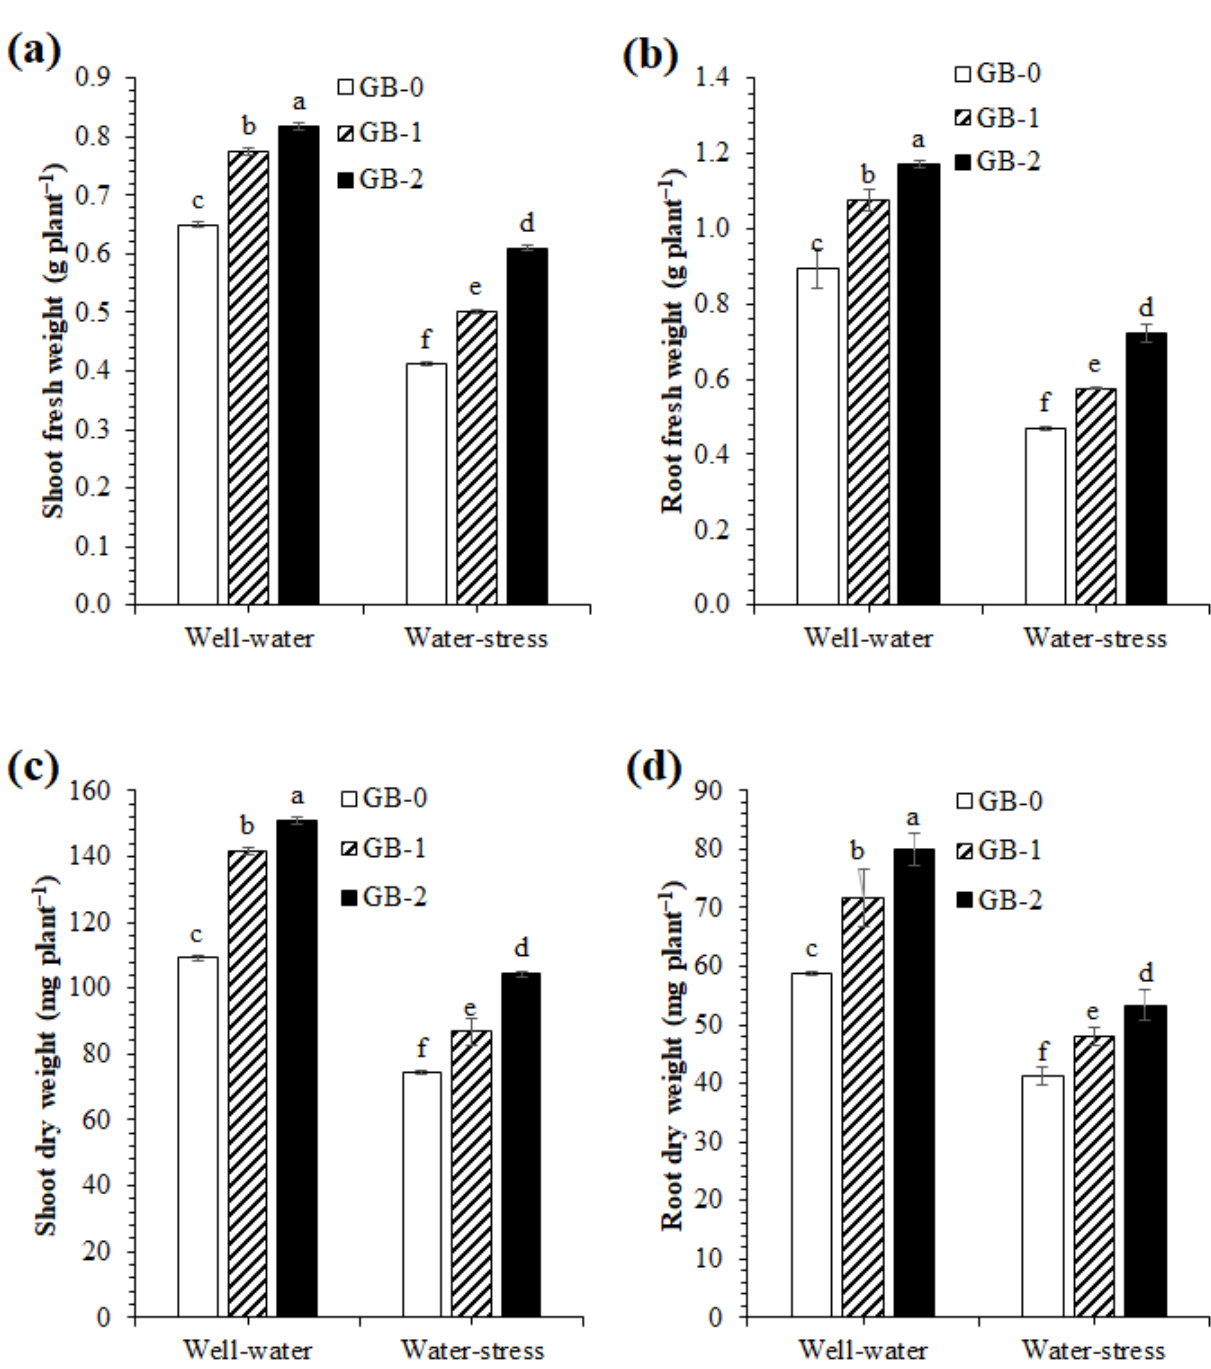
Figure 2. Effect of GB root-priming on shoot ( a , c )/root ( b , d ) fresh weight and dry matter accumulation of wheat seedling grown under well-water and water-stress conditions. Each value represents the mean ± standard deviation (SD) of three replicates. Bars showing different letters represent the significant differences at p ≤ 0.05 as determined by LSD test.